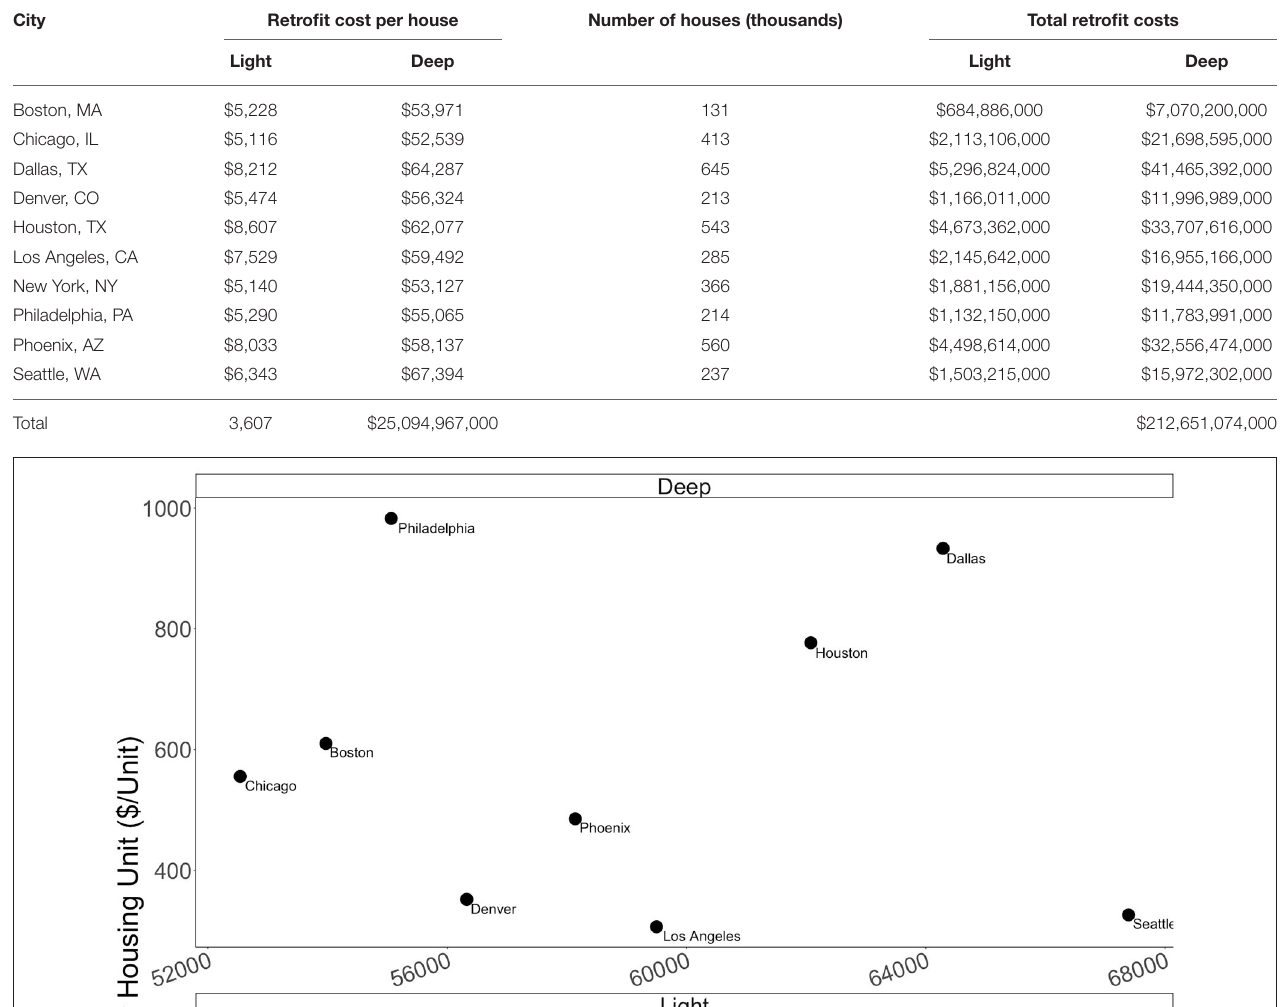
Frontiers in Sustainable Cities |